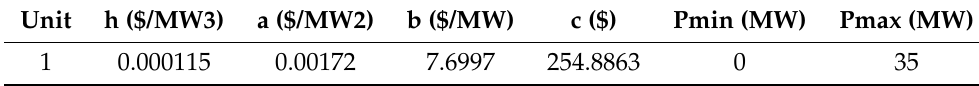
Table A4. Electrical Energy Generator unit data for Case Study